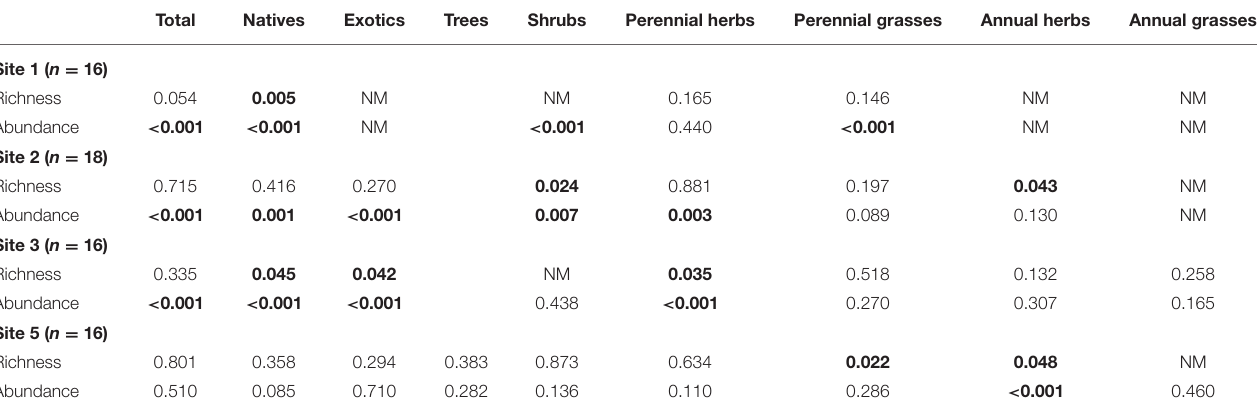
TABLE 4 | P -values for fuel treatment and steppe factor for richness and abundance variables at each site. Total